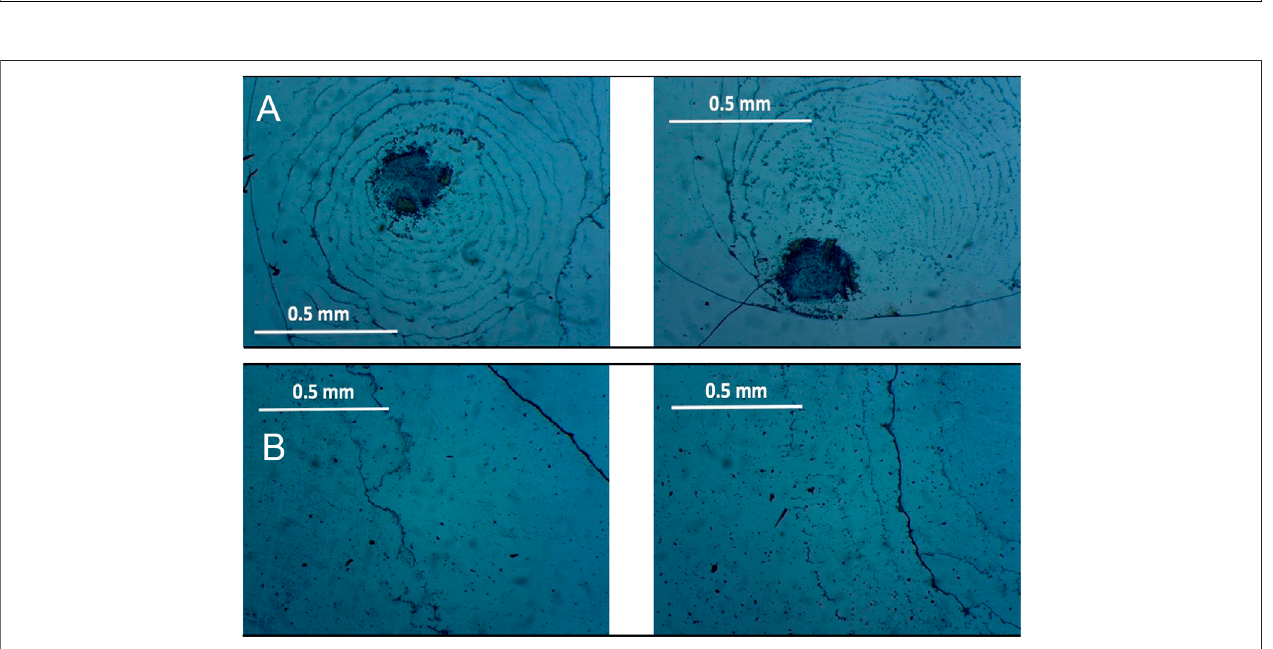
FIGURE12| Examplesofphotos ofmicrosphere distribution indried dropsin 1 × 10 – 31 MHyFn (upperrow, (A) )and ofphotos ofmicrospheredistributionin dried water droplets, corresponding to a HyFn dilution of 1 × 10 – 31 M (lower row, (B) ).